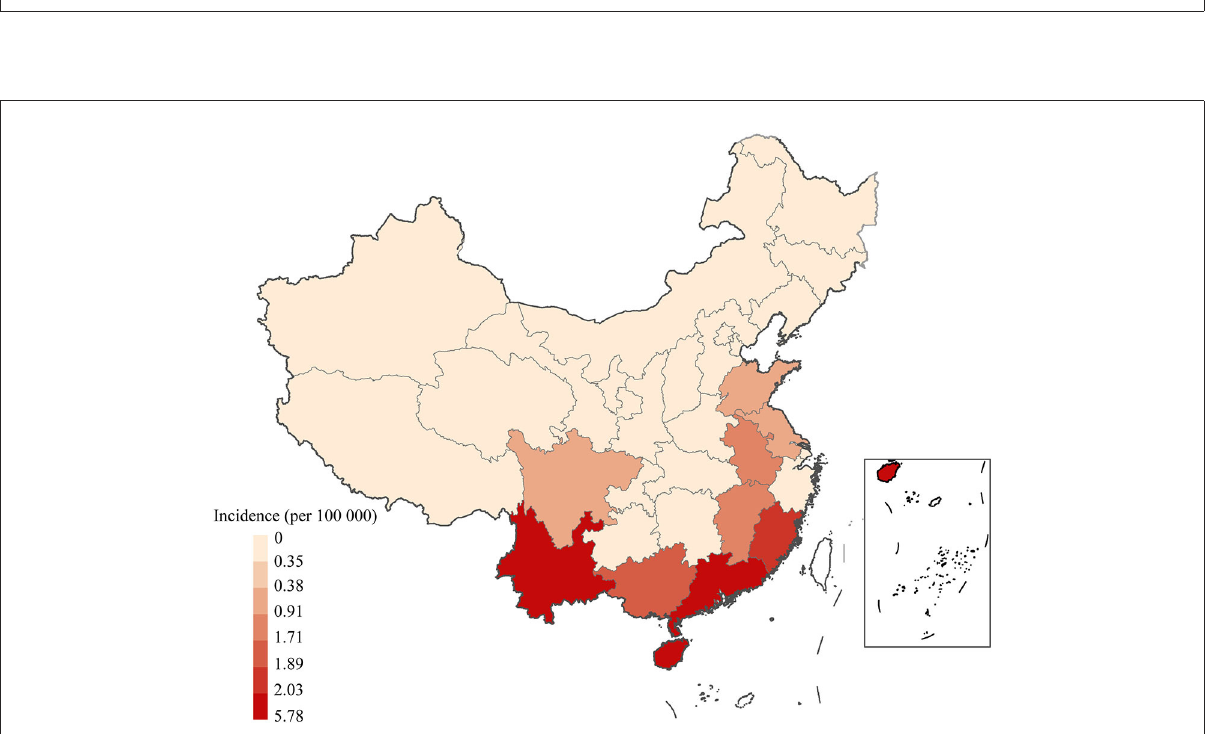
FIGURE3 Spatiotemporal distribution of scrub typhus in China from 2006 to 2018. Annual incidence of scrub typhus per 100,000 people in the 31 Chinese provinces